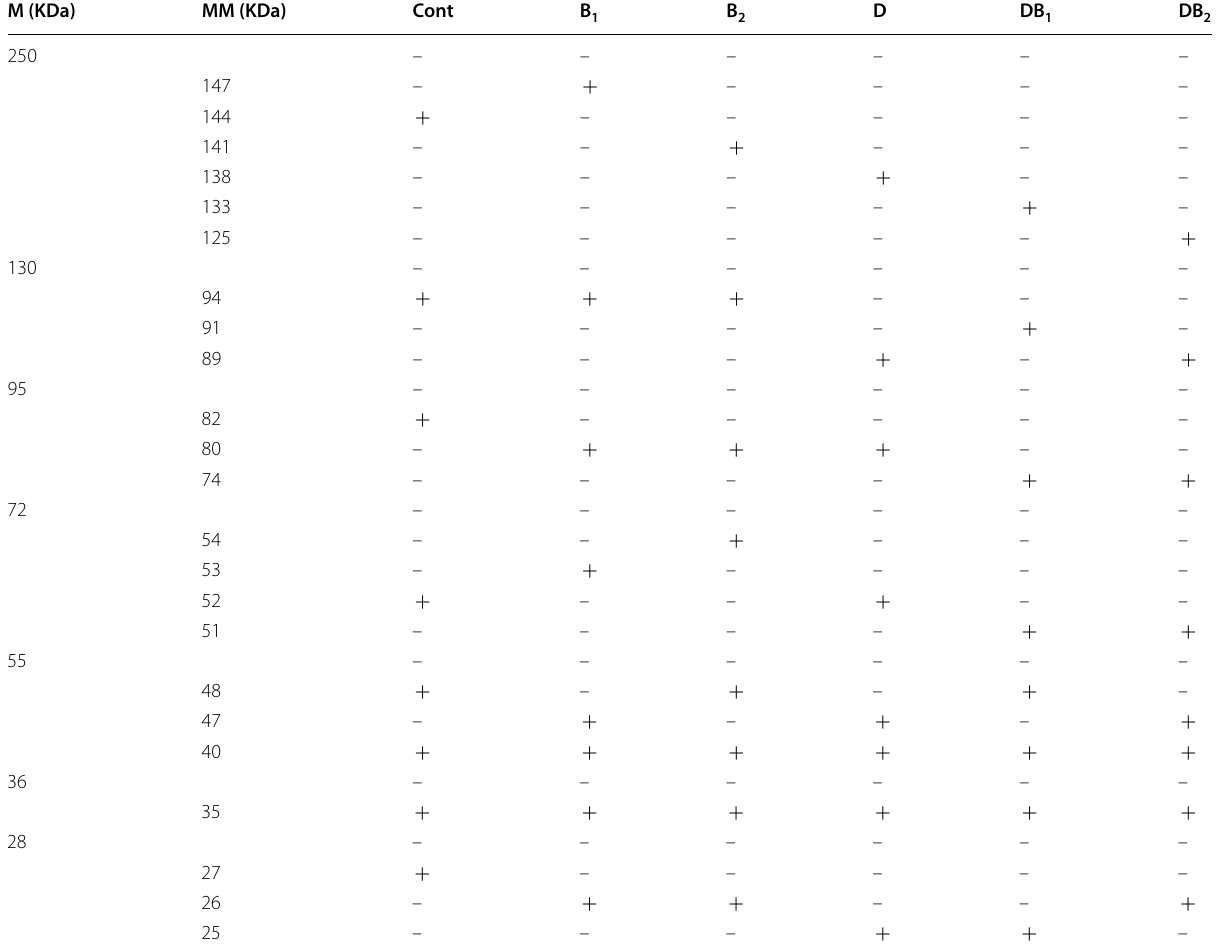
) and Stenotrophomonas maltophilia B11 (B ) 1 2